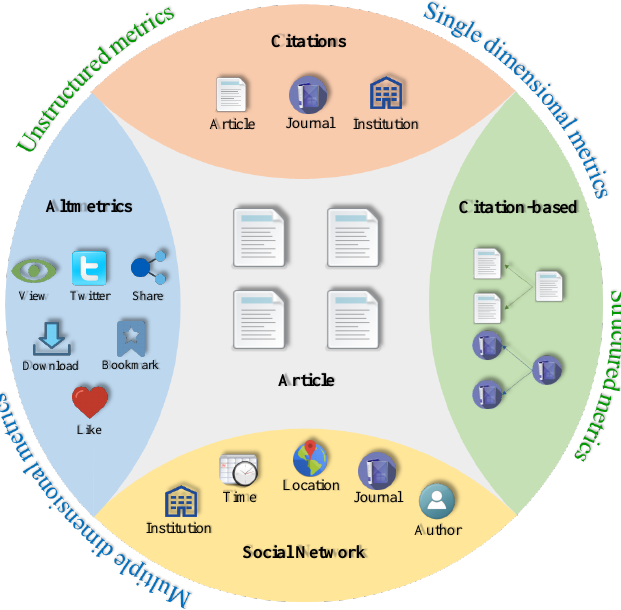
Figure 1. Methods of evaluating and predicting article